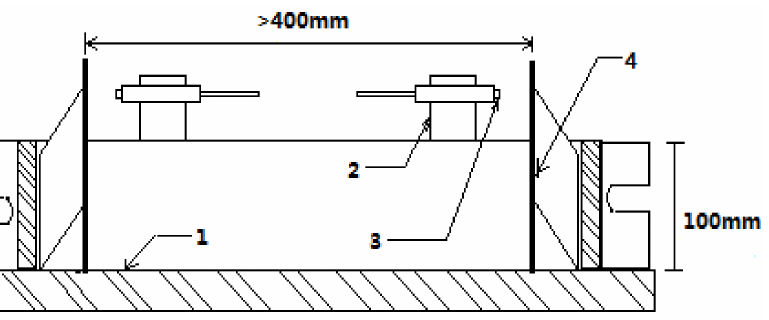
Figure 6. Non-contact concrete shrinkage deformation testing system (1—steel mold; 2—sensor support; 3—displacement sensor; 4—standard